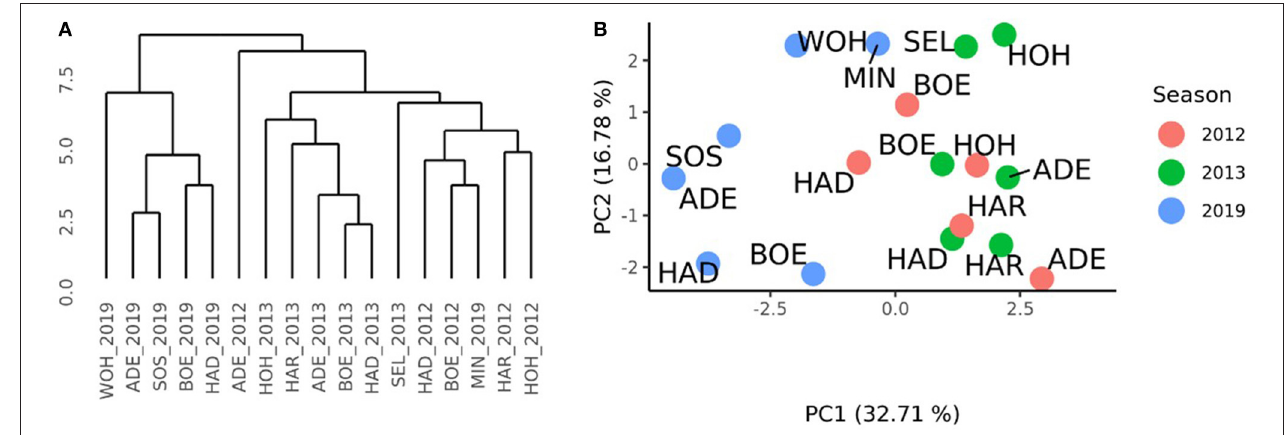
FIGURE 5 | Characterization of the environments of the HYWHEAT and RRGS experiments of the growing seasons 2011/2012, 2012/2013, and 2018/2019, based on satellite-based images. (A) Dendrogram based on the mean vegetation condition index (VCI) profiles of 16 location times year combinations (location_year) used to perform grain yield trials in the year 2012 and 2013 for the training population and in the year 2019 to assess the selection gain of the reciprocal recurrent genomic selection program. (B ) PCA based on the mean VCI profiles of 16 location times year combinations. The locations were indicated as ADE, Adenstedt; BOE, Boehnshausen; HAD, Hadmersleben; HA R, Harzhof; HOH, Hohenheim; MIN, Mintraching; SEL, Seligenstadt; SOS, Sossmar; WOH, Wohlde.